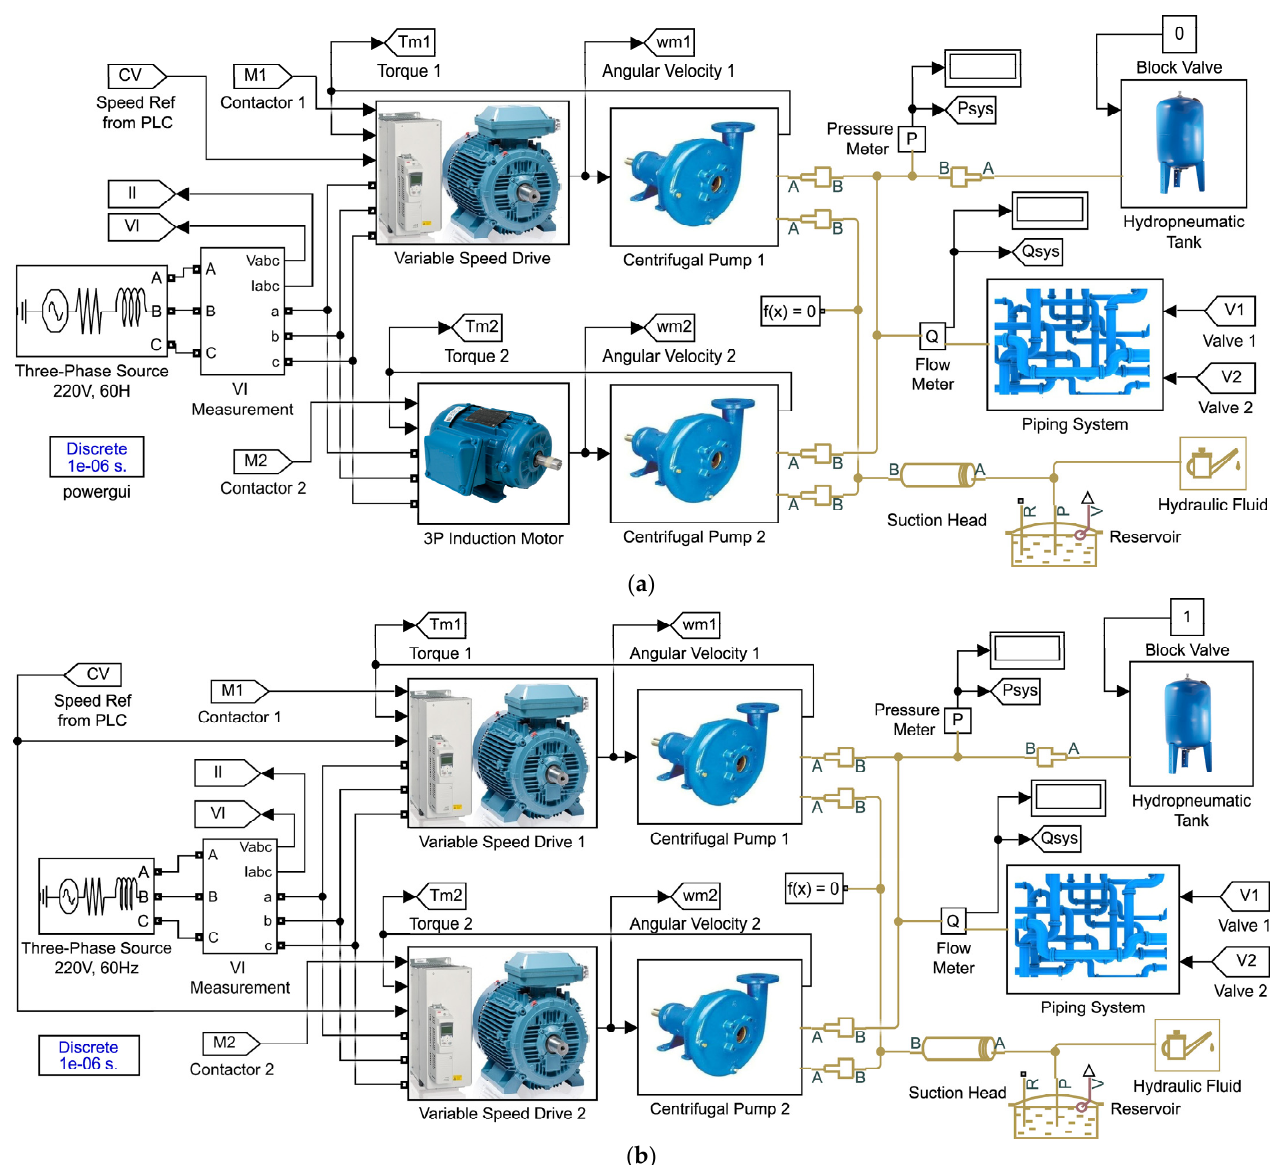
Figure 4. Case studies modeled in Simulink: ( a ) Case one: only one pump at variable speed. ( b ) Case two: both pumps at variable speed.